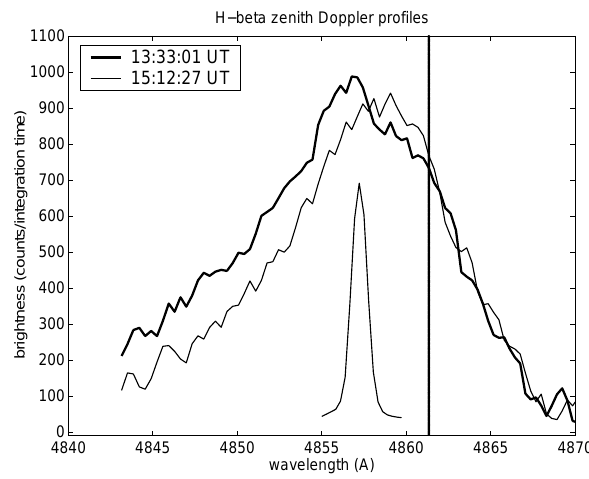
Fig. 2. H β profiles at times of increased intensity (marked with arrows in Fig. 1a). The instrument function is